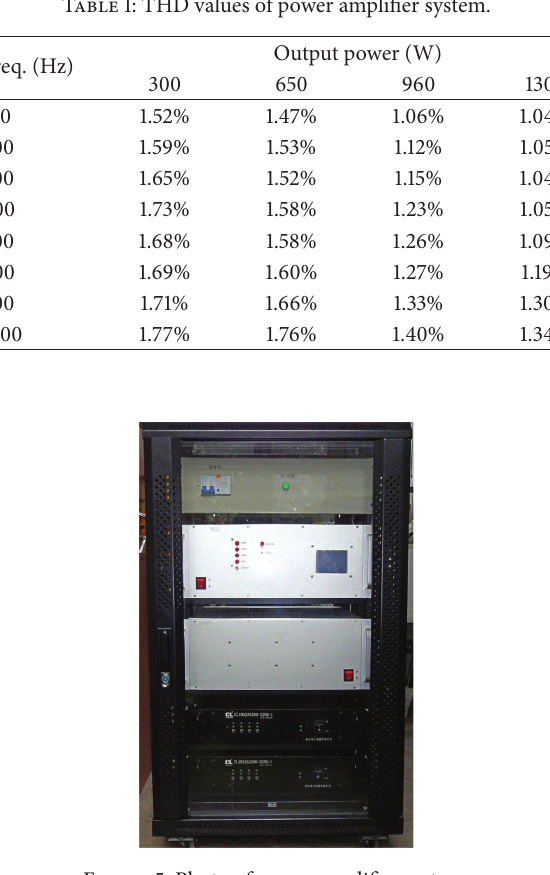
Figure 5: Photo of power amplifier system.